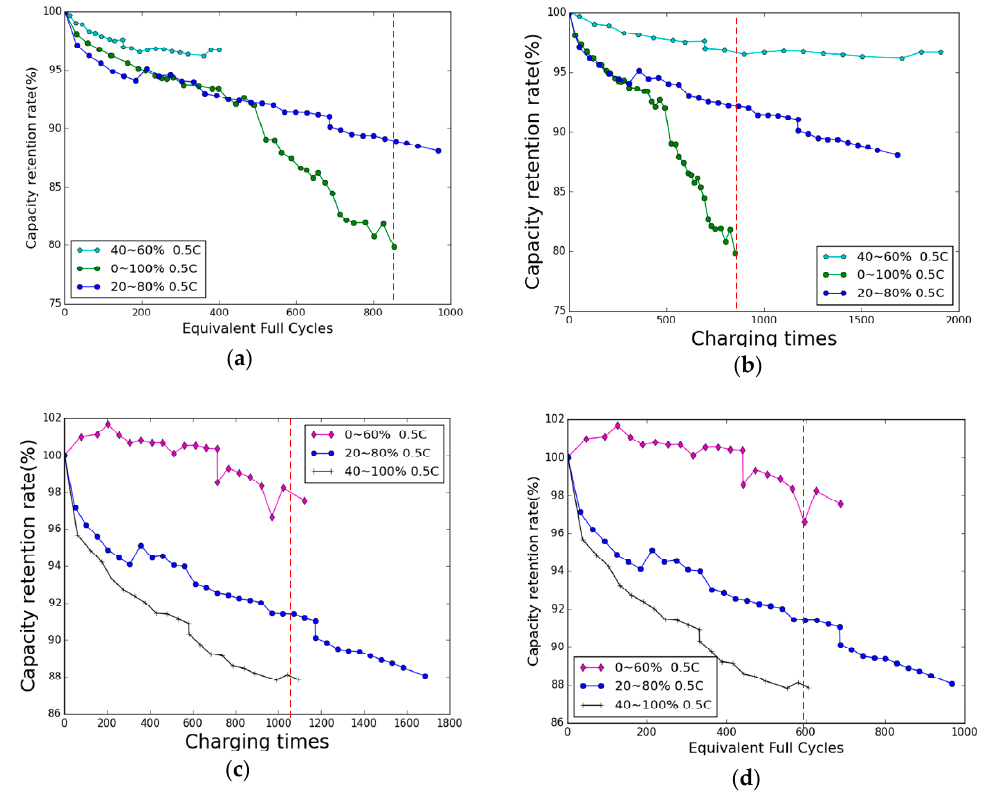
Figure 2. ( a ) Battery capacity retention rate versus equivalent full cycles of batteries cycling at 50% mean SOC ; ( b ) battery capacity retention rate versus charging times of batteries cycling at 50% mean SOC ; ( c ) battery capacity retention rate versus equivalent full cycles of batteries cycling at 60% Δ SOC ; and ( d ) battery capacity retention rate versus number of charging times of batteries cycling at 60% Δ SOC .